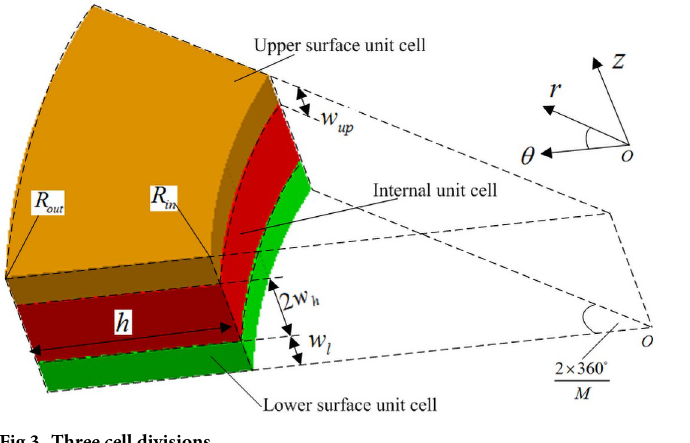
Fig 3. Three cell